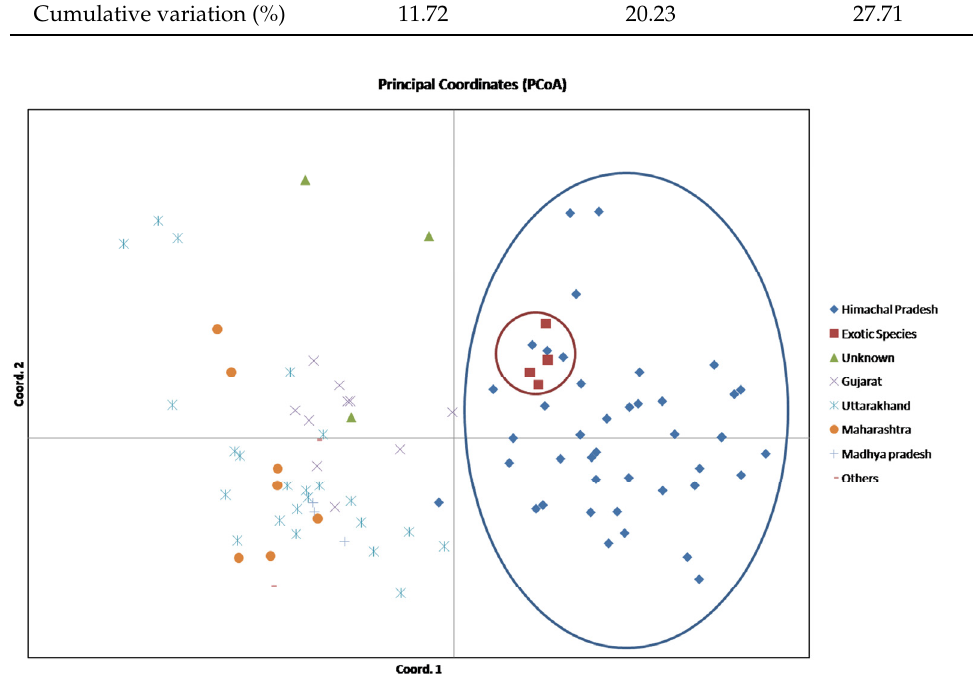
Figure 6. Principal coordinates analysis (PCoA) plot showing the distribution of 94 accessions ac- cording to 36